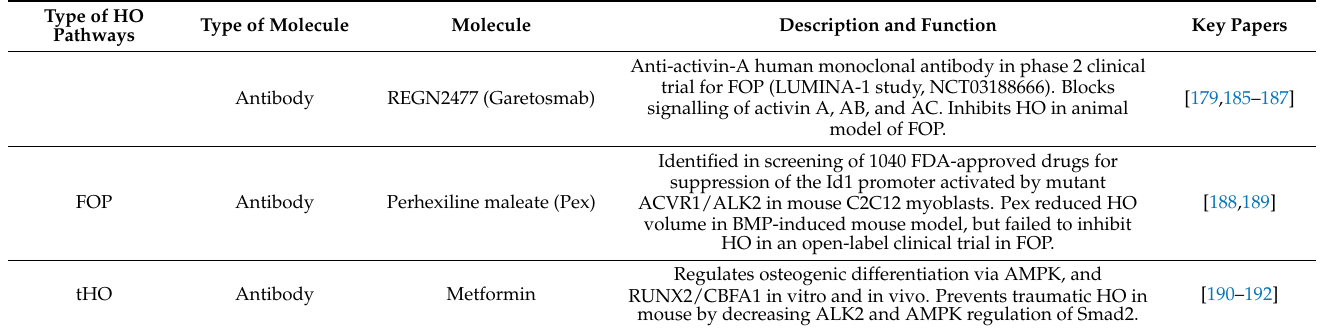
Table 3. Summary of investigational therapeutic strategies for the inhibition of heterotopic ossifica- tion, based on ALK2 signalling and other pathways. FOP = fibrodysplasia Ossificans Progressiva, tHO = acquired post-traumatic Heterotopic